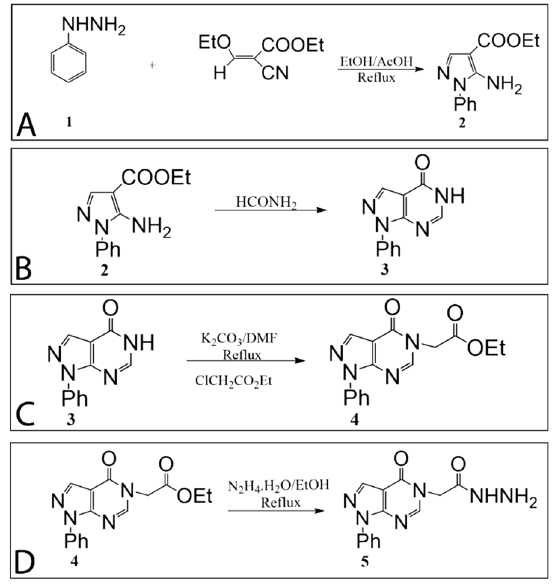
Fig. 4 Synthesis of the compounds 2 , 3 , 4, and